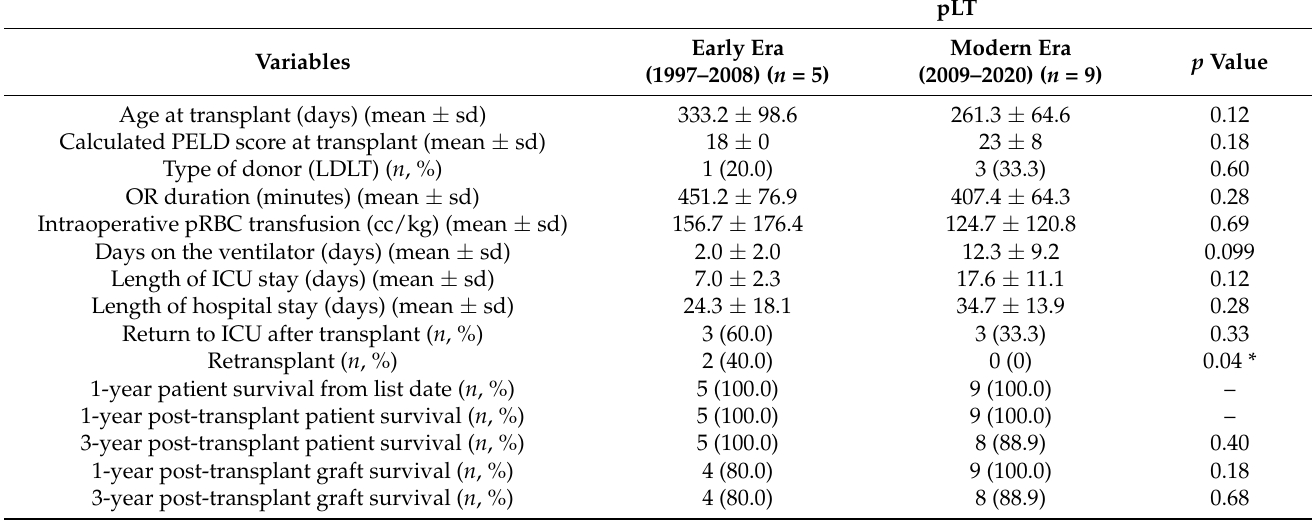
Table 8. Post-transplant comparison of patients transplanted after pLT based on era: transplant- related data and post-transplant outcomes